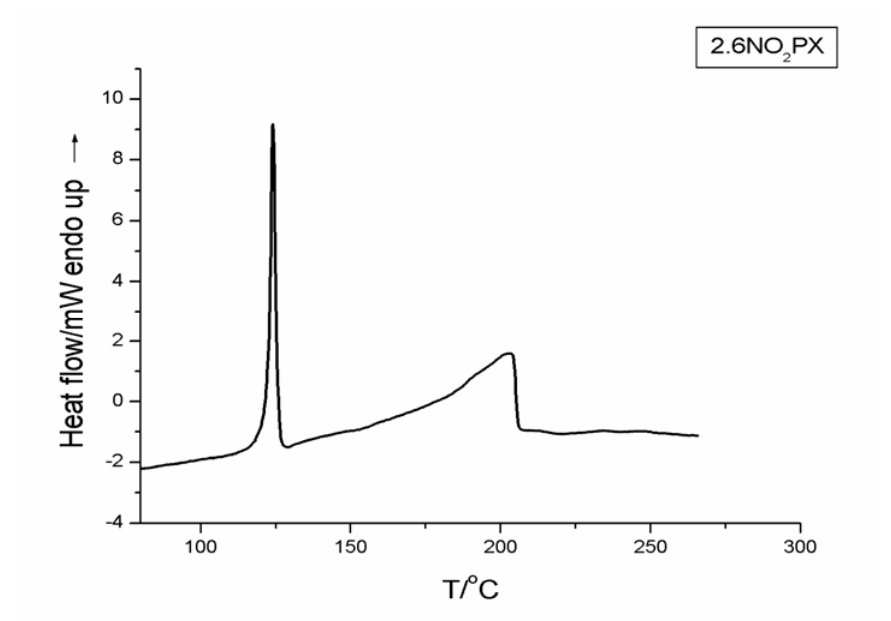
Figure 4. DSC curve of the 2,6-DPX